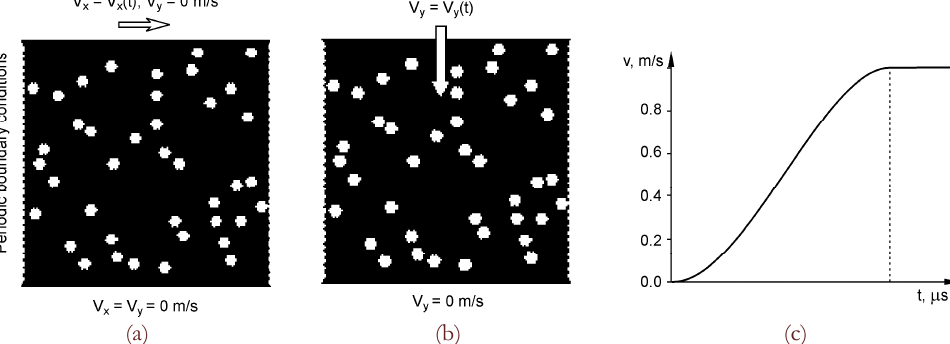
Figure 1: Initial structure of a model specimen with a size of h = 60 μ m and scheme of loading for shear (a) and uniaxial compression (b); the plot of velocity vs time for the upper automaton layer of the specimen